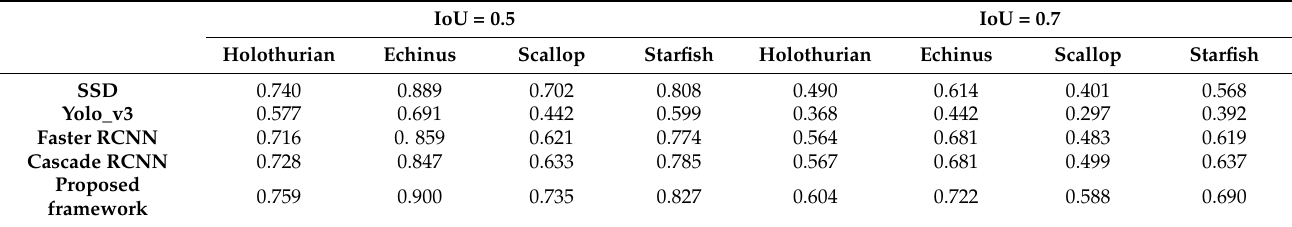
Table 5. Detection recall of different models for various underwater targets with IoU thresholds of 0.5 and 0.7.